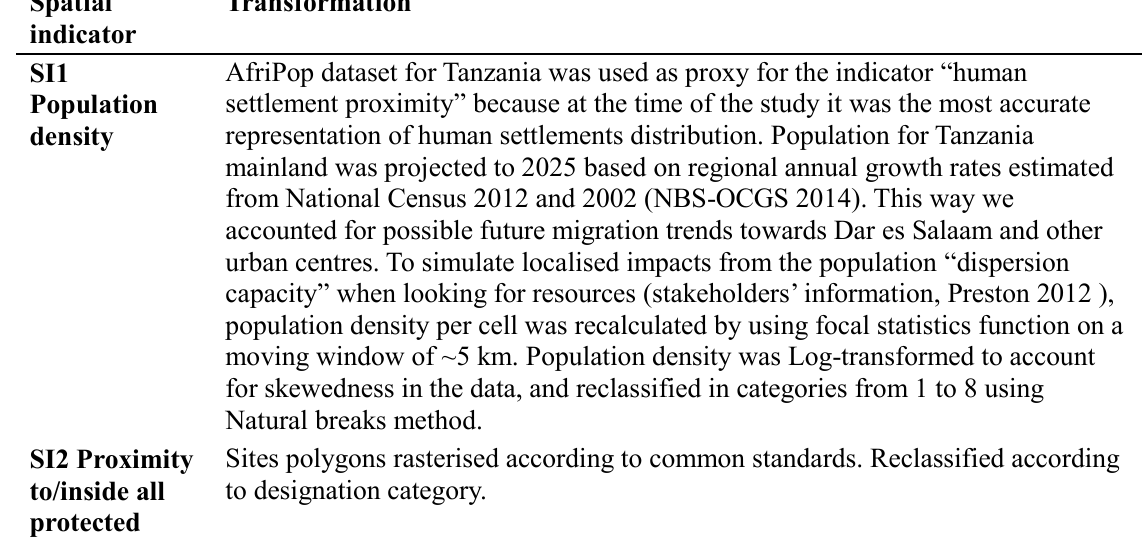
Table A2.3: Transformation and reclassification criteria for the spatial indicators of likelihood of LULC change. All datasets were converted to raster layers, adopting as common standard the Coordinate Reference System (CRS) and spatial resolution (sr) of Tanzania AfriPop dataset (CRS: WGS1984, sr= 0.000833333 decimal degrees). The transformed spatial indicators were then projected to UTM37 South (sr = 93.319 m at the equator) and clipped to the extent of the reference LULC map (MNRT